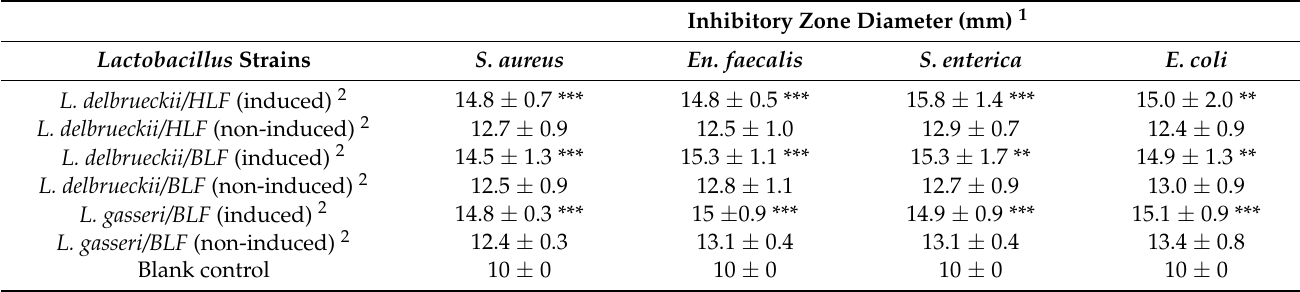
Table 2. Average inhibitory zone against food-borne pathogens of recombinant probiotic strains. Agar diffusion test showing the antibacterial activity of cleared supernatants prepared from induced and non-induced recombinant probiotic strains. Inhibitory Zone Diameter (mm)